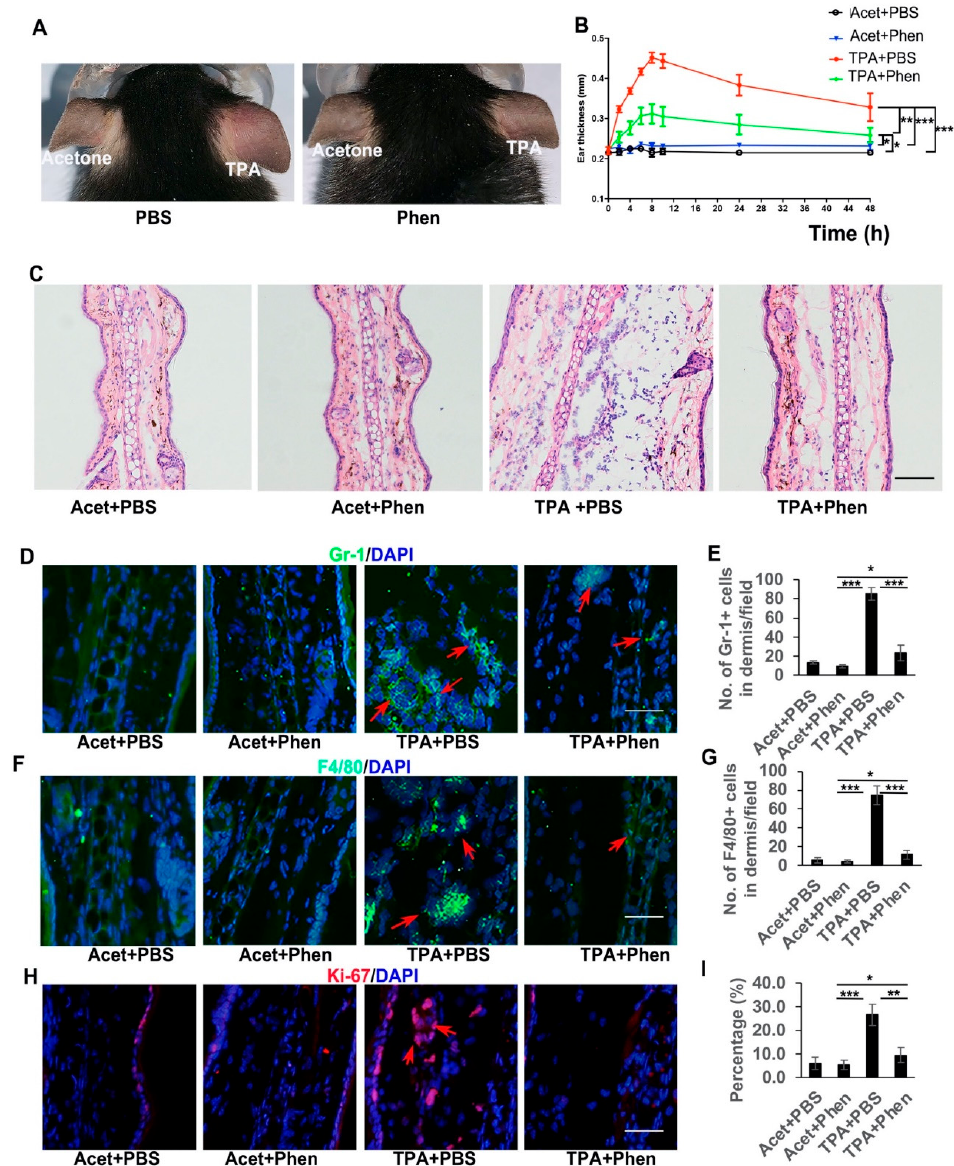
Figure 1. Phenformin suppresses acute skin inflammation induced by TPA. ( A ) Representative images of the ears of mice treated with PBS (as a control) or with phenformin (Phen, 150 mg/kg) with the topical application of acetone on the left ears or TPA on the right ears at 8 h after treatment. ( B ) Ear thicknesses of mice from ( A ) were measured at different time points as indicated. Two-way ANOVA with correction for multiple pairwise comparisons was used for statistical analysis of differences between two groups as indicated, n = 3, standard deviation bars are shown, * p < 0.05; ** p < 0.01; *** p < 0.005. ( C ) Histological analysis of the ears of mice from ( A ) at 8 h after TPA treatment, quantification of ear thickness seen by HE stain is shown in Supplementary Figure S2; ( D – I ) Sections from ( C ) were analyzed for infiltration of inflammatory cells by IF analysis of Gr-1 (( D ), green) and F4/80 (( F ), green) and cell proliferation by IF analysis of Ki67 (( H ), red); DAPI is used as a counterstain for nuclei, lower-magnification images of ( D , F , H ) are shown in Supplementary Figure S3. The corresponding quantification analysis of the number of Gr-1 or F4/80 or Ki67-positive cells per field ( D , F , H ) is shown in ( E ) (Gr-1), ( G ) (F4/80) and ( I ) (Ki67). ( E , G , I ): Student’s t test analysis was used for all quantification data to compare two groups as indicated, n = 3, standard deviation bars are shown, * p < 0.05; ** p < 0.01; *** p < 0.005. Bars: 100 µ m in ( C ); 50 µ m in ( D , F , H